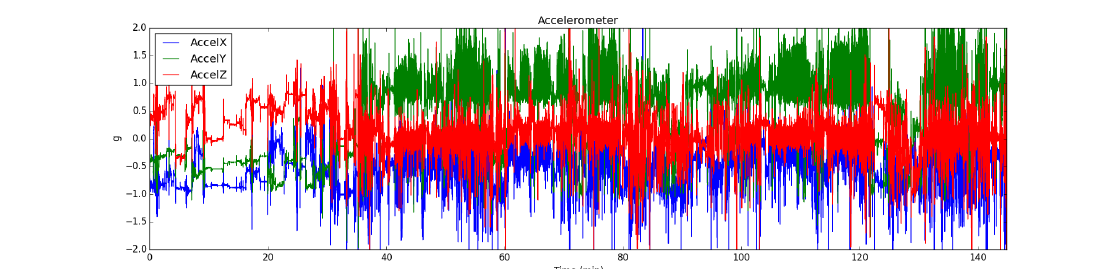
Figure 4. Activity intensity is shown by using the accelerometer sensor X, Y, and Z components corresponding to the example EDA signal in Figure 3 Note that this example was recorded during a highly intensive activity.